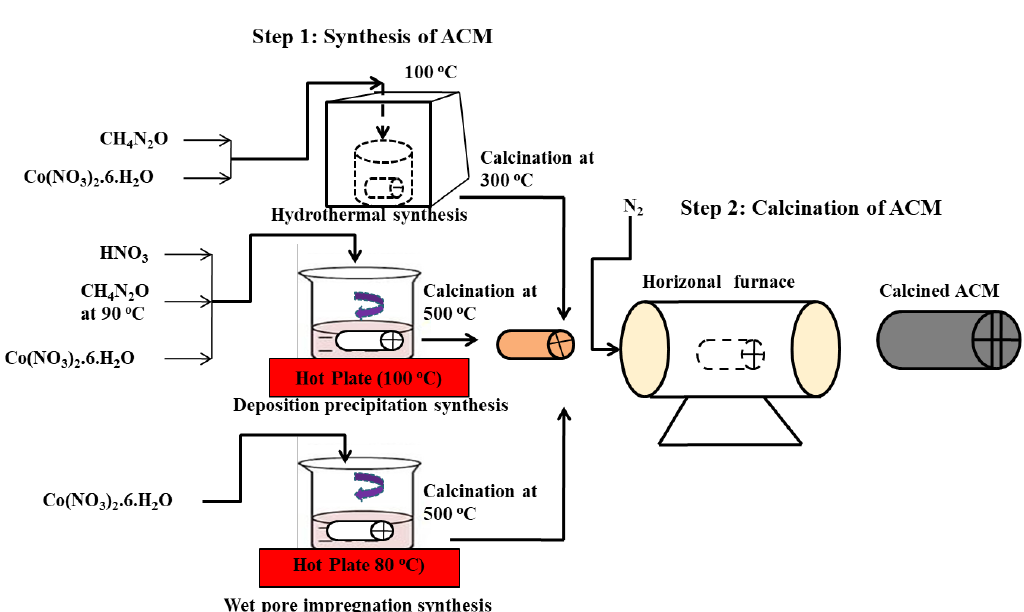
Figure 3. Schematic representation of synthesis procedure.